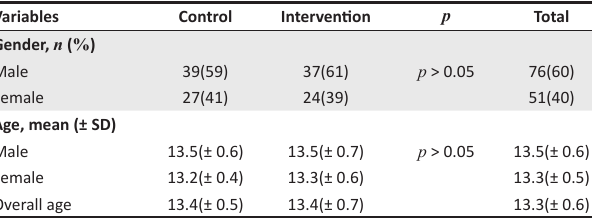
FIGURE 1: Consort diagram showing the flow of participants in the randomised control trial study. TABLE 1: Demographic characteristics of the learners ( n = 127).